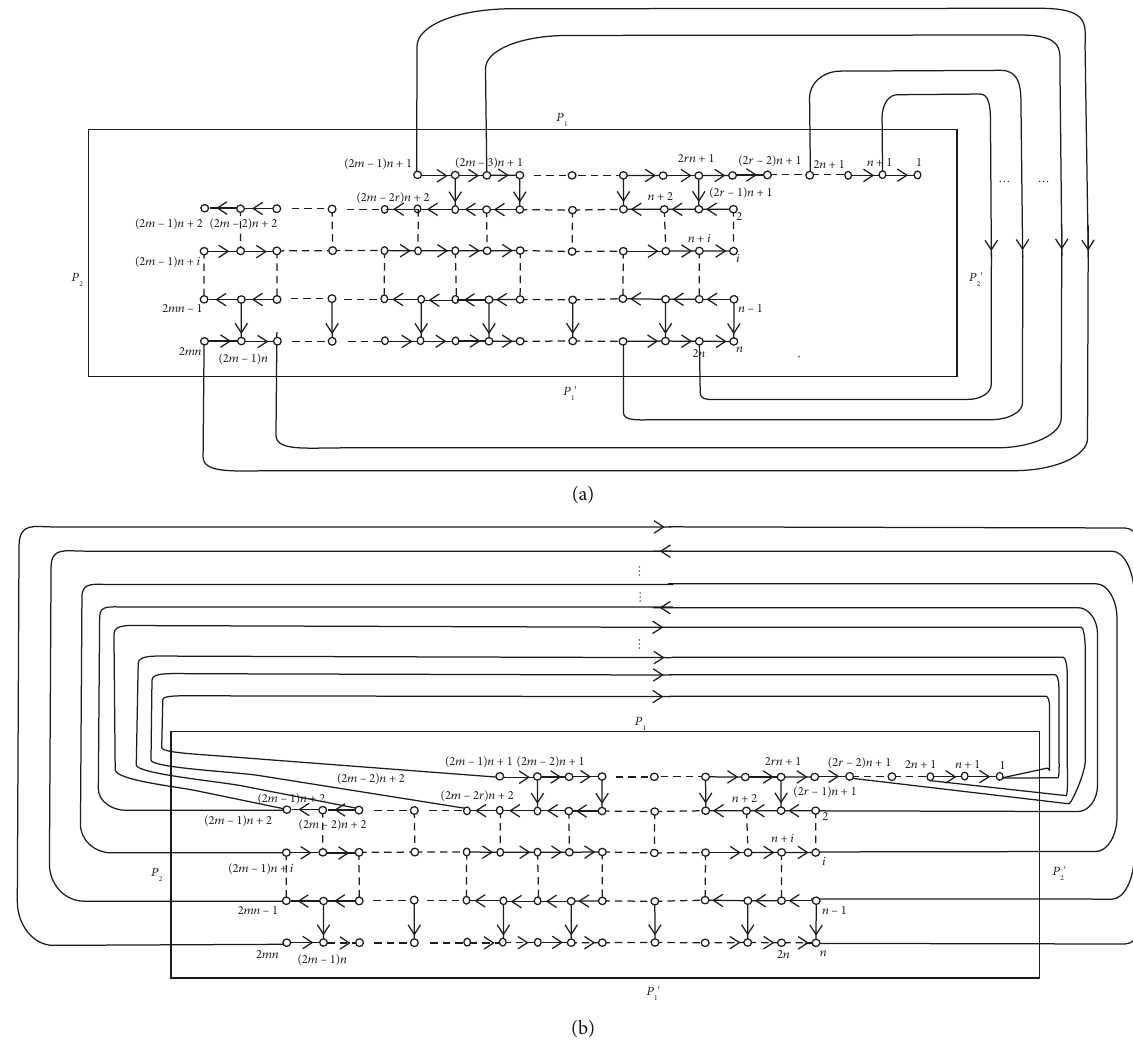
Figure 6: A crossing orientation of H